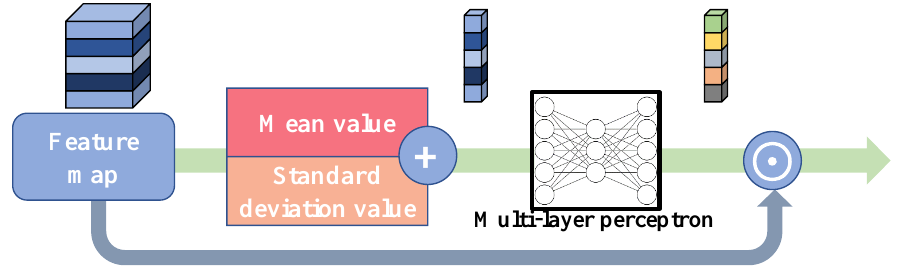
Figure 6. Differential channel attention block (DCA).